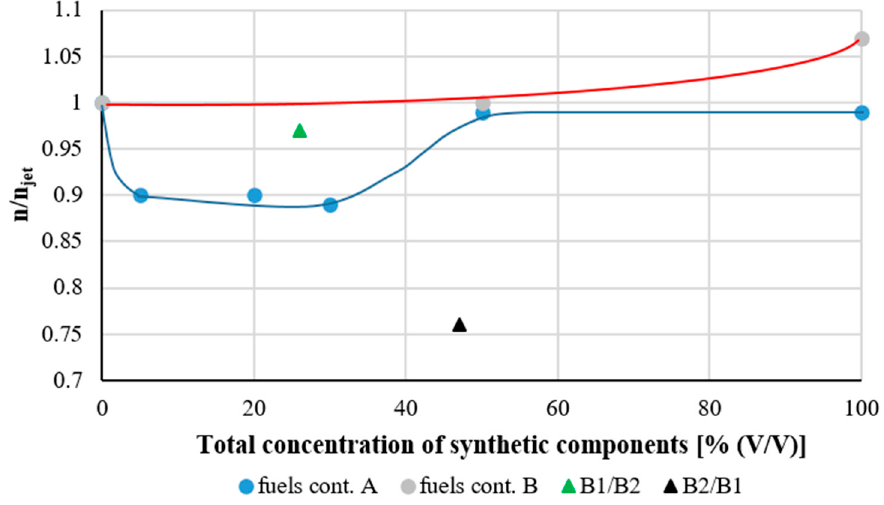
Figure 10. Dependences a/a Jet and n/n Jet on the total concentration of synthetic components A and B.